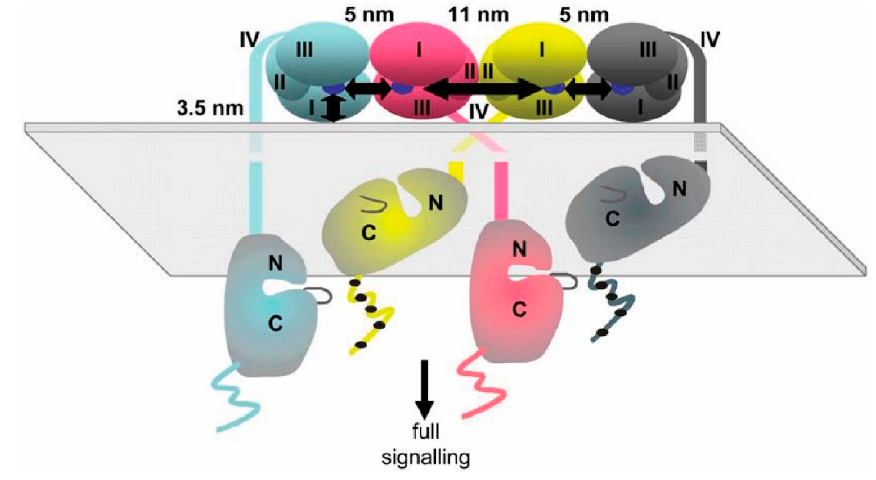
Figure 8. Model of EGFR signaling complex derived from single-molecule and ensemble FRET measurements described in Webb et al. (2008) [92]. EGF is bound to receptors in a tetramer involving a combination of two distinct configurations. Cyan, magenta, yellow, and grey structures each represent an individual EGFR molecule in the complex. The Roman numerals I–IV refer to domains of the EGFR, and “N” and “C” indicate the positions of the N and C termini of the intracellular domain of the receptor.